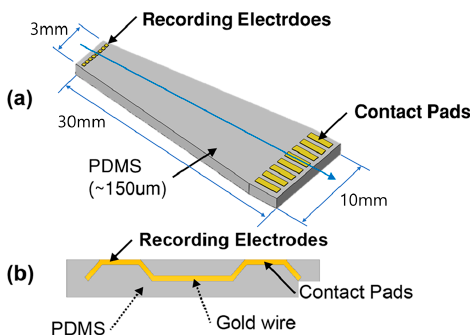
Figure 1. 3D schematic of the electrode array. ( a ) Schematic of a polydimethylsiloxane (PDMS)-based multielectrode array. ( b ) Cross-section along the blue arrowed line in ( a ). multielectrode array. ( b ) Cross-section along the blue arrowed line in ( a